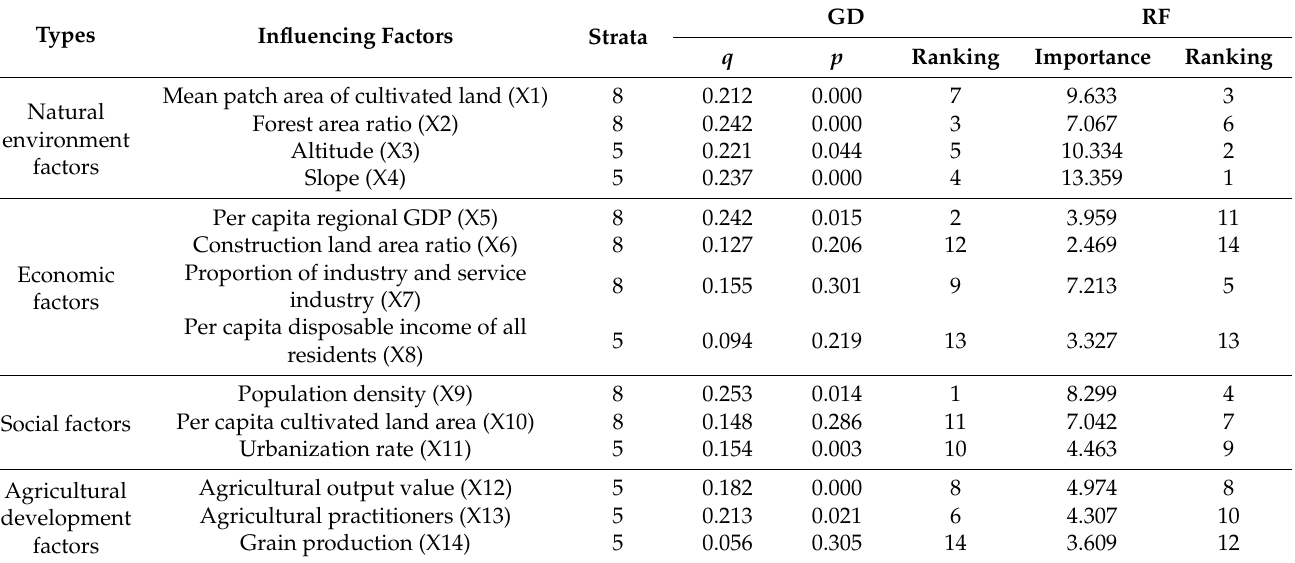
Table 6. Detection of factors influencing spatial difference in CLF in Guangdong